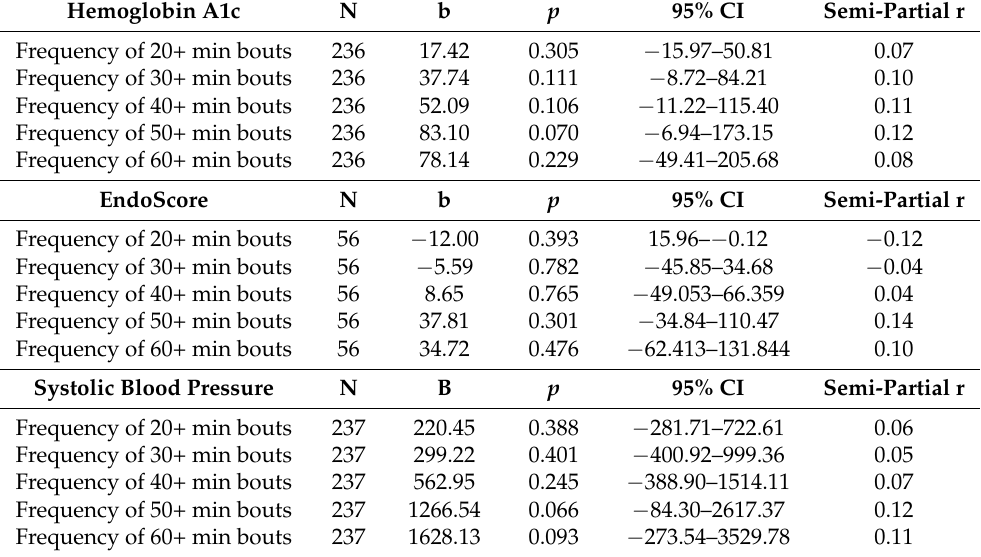
Table 2. Regression Coefficients for Frequency of Uninterrupted Sitting Bouts and Physiological